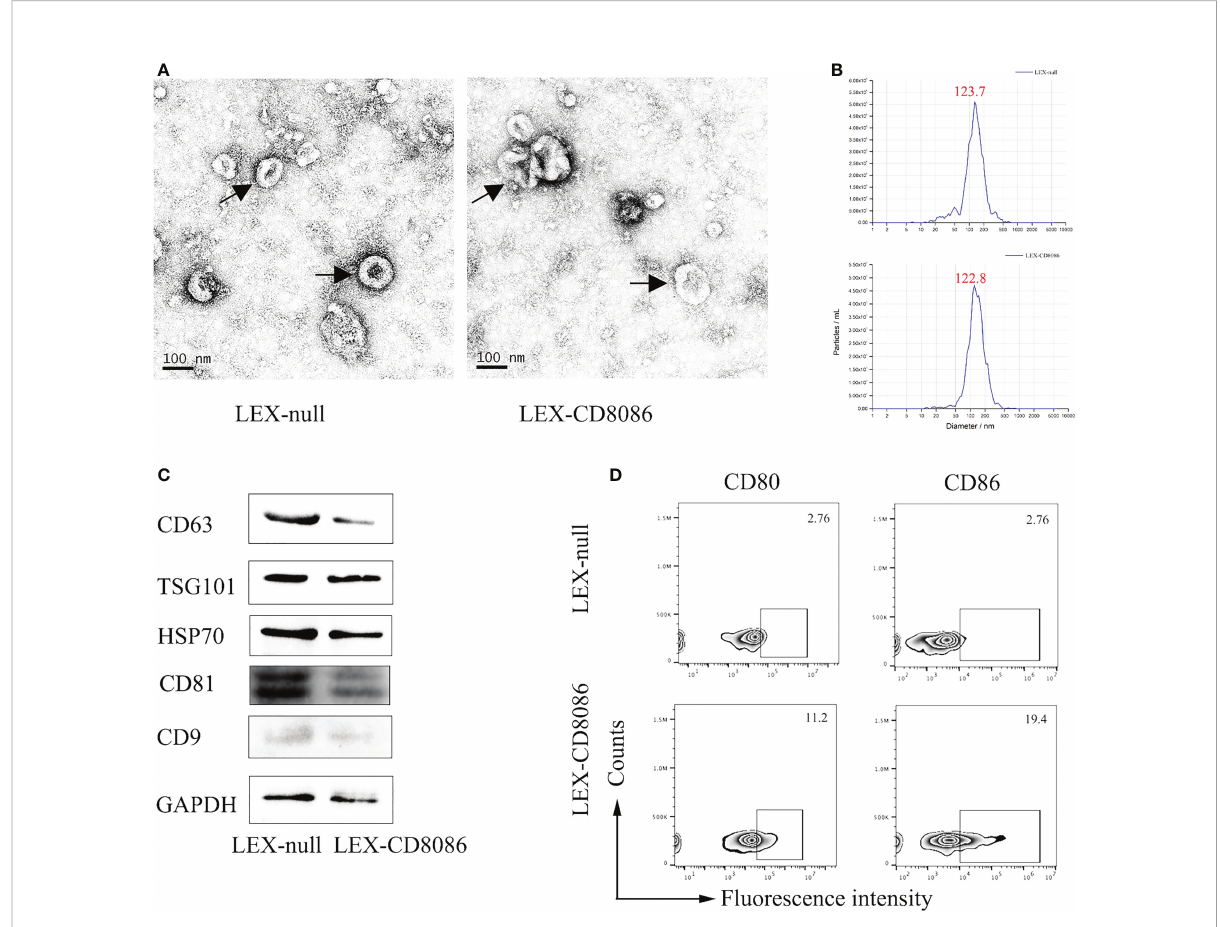
FIGURE 2 Characterization of exosomes derived from LEX-CD8086 cells. (A) The morphology of the LEX derived from of L1210-null cell (LEX-null, Left) or L1210-CD8086 cell (LEX-CD8086, Right) determined by transmission electron microscopy. Black arrow indicates exosome. (B) Size distribution of LEX. The size distribution of exosomes determined by nanoparticle tracking. Peaks at 123.7 nm (LEX-null, above) and 122.8 nm (LEX-CD8086, below). (C) The exosomal protein markers of LEX-CD8086 and LEX-null were detected by western blotting. (D) The CD80 and CD86 expressions of LEX-CD8086 were determined by fl ow cytometry, LEX-null was used as the